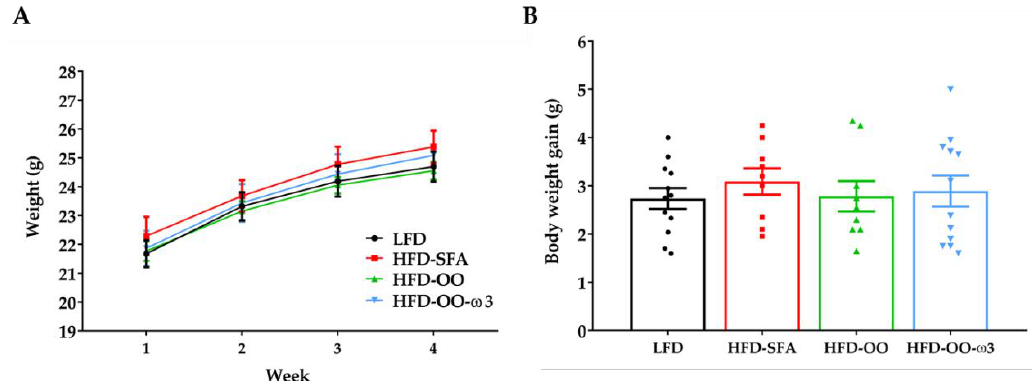
Figure 2. ( A ) Body weight monitoring and ( B ) Body weight gain. Experimental diets: LFD (Black), HFD-SFA (Red), HFD-OO (Green), and HFD-OO-ω3 (Blue). No significant differences between the groups were found after ANOVA. The results represent the mean ± standard error of the mean (SEM)